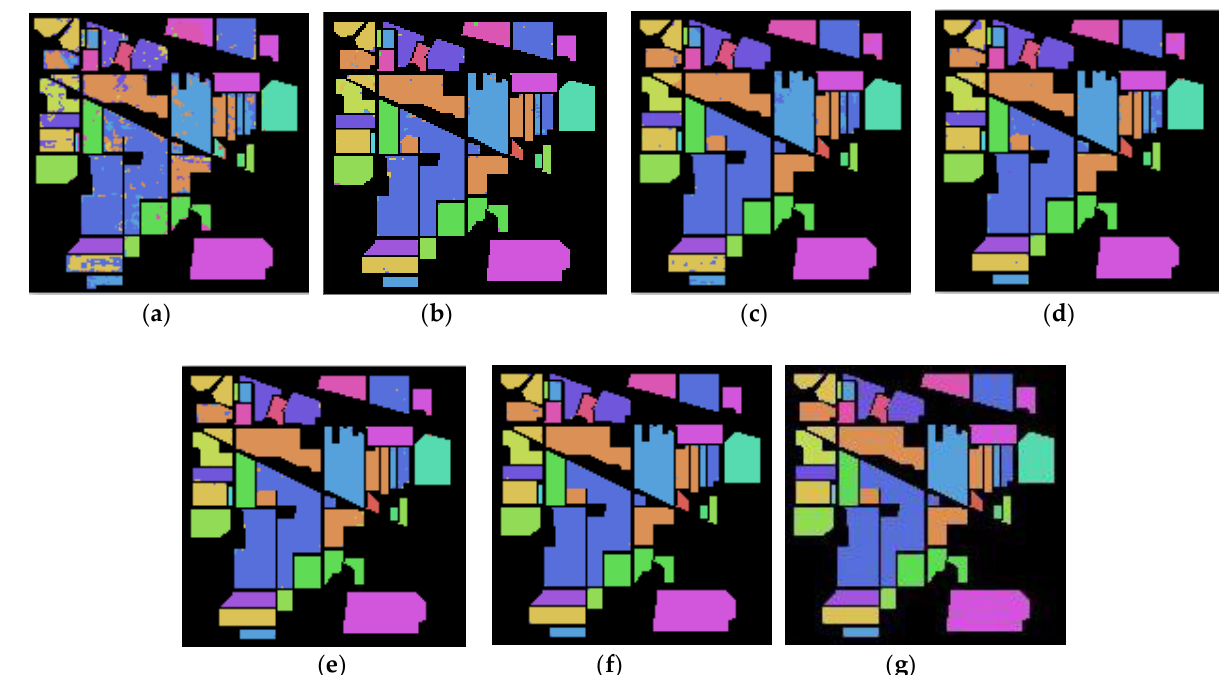
Figure 17. ( a – g ) Classification map of PCA, SVM, 2D-CNN, 3D-CNN, RES-3D, SSRN, and proposed on Indian Pines